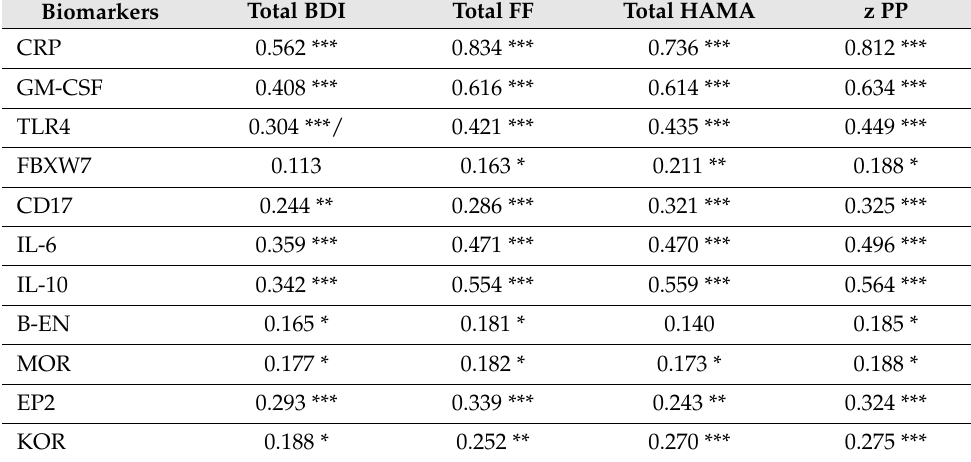
Table 4. Intercorrelation matrix between psychopathology rating scales and biomarkers. Biomarkers Total BDI Total